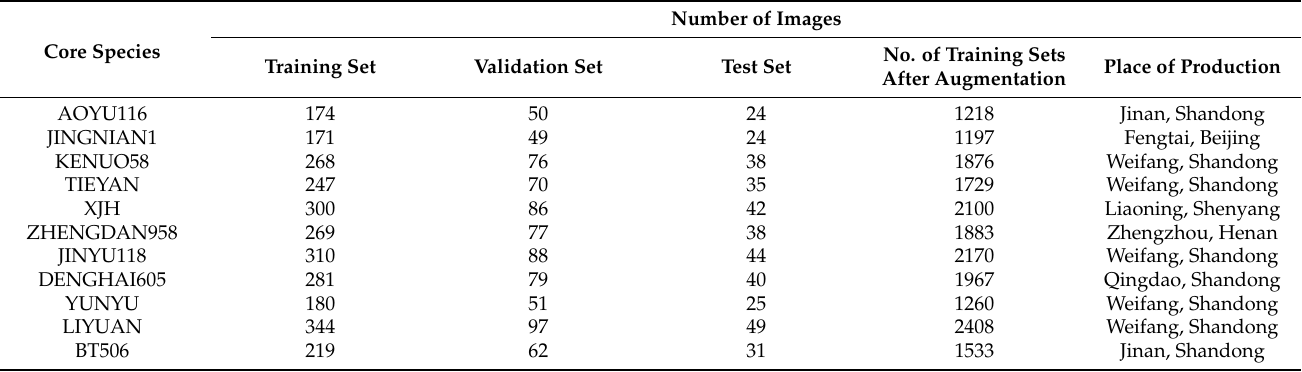
Table 1. Dataset of maize seeds (double-sided